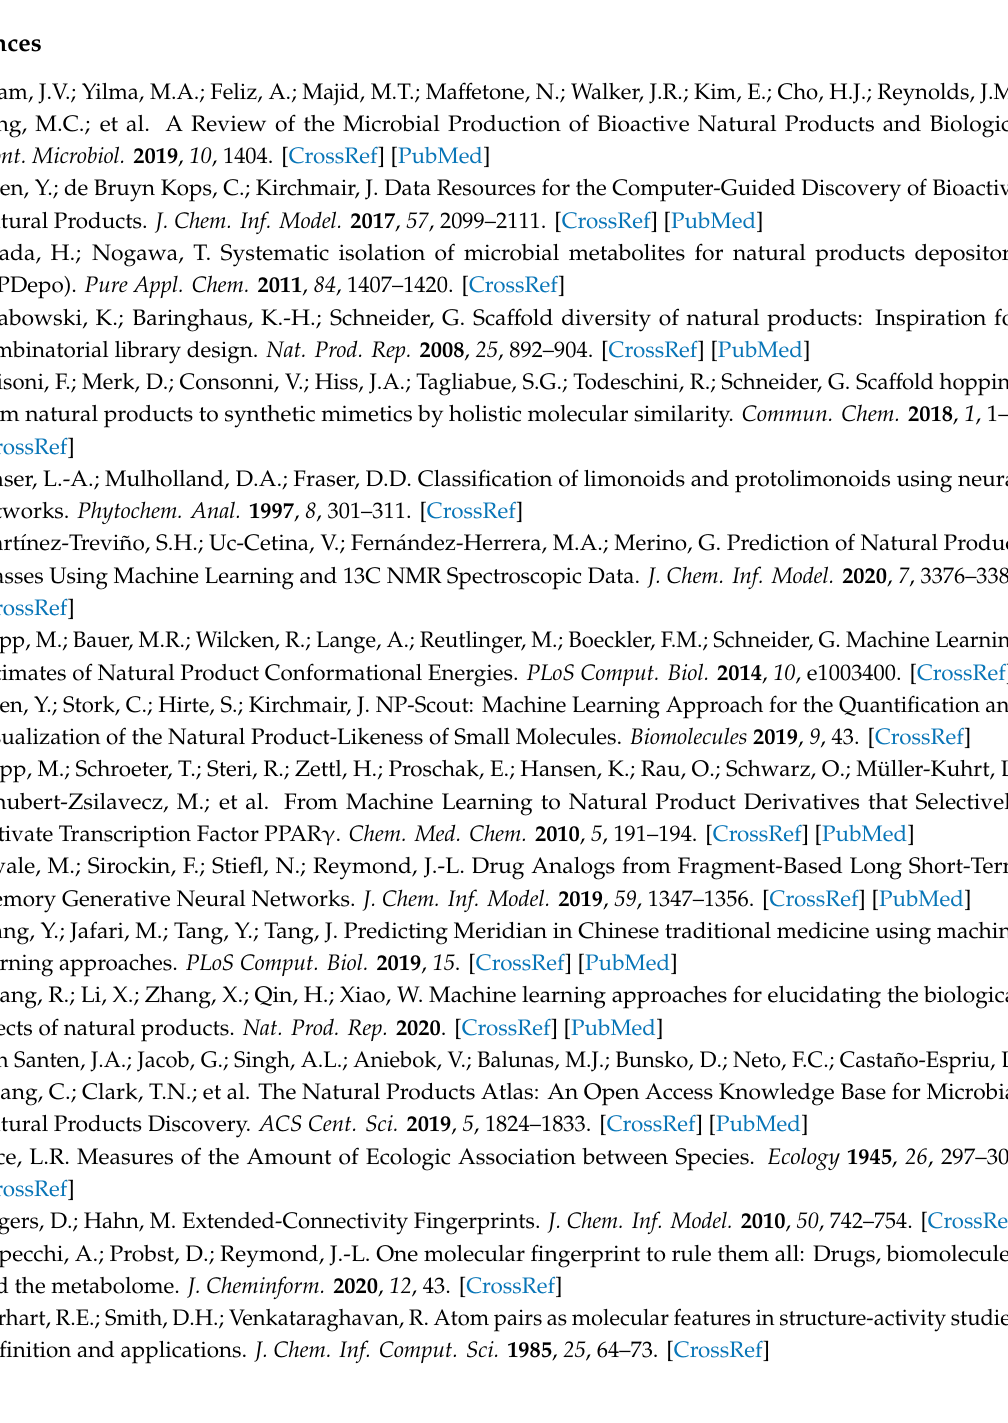
continuous properties. Figure S4: MAP4 TMAP of NPAtlas colored with the ranked continuous properties. Figure S5: MAP4 TMAP of NPAtlas colored with the available categorical properties. Table S1, Figure S6: MAP4 SVMN classification of known non-microbial natural products and their